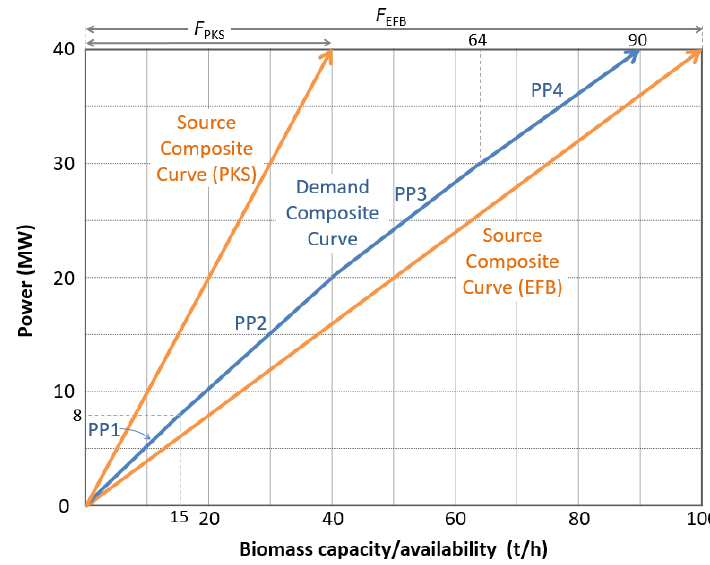
Figure 7. BEPD when single biomass is used (Scenario 1).